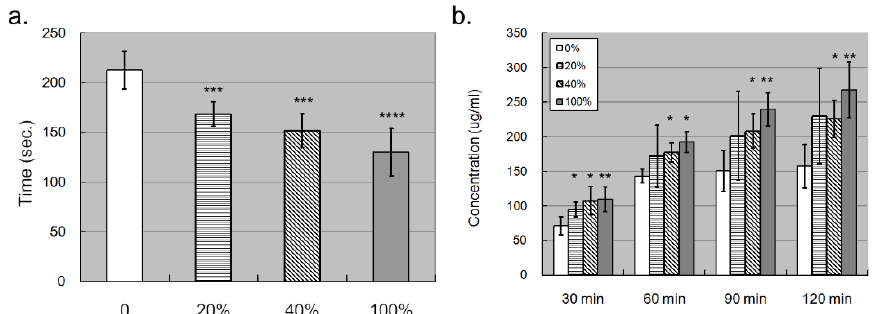
Figure 5. Trans-well assay showed that S100A4 promoted the permeability of the endothelial layer composed of HCAECs. We also used trans-well kits to examine whether S100A4 affected the per- meability of the endothelial layer. ( a ) The permeability of the endothelial layer was quantified by counting how much time was needed for trypan blue to reach the lower chamber ( n = 3). ( b ) The permeability of the endothelial layer was quantified by measuring the concentration of total proteins in the lower chamber ( n = 3). Data were presented as mean ± SD. *, **, *** and **** with a denoted p -value < 0.05, 0.01, 0.001, and 0.0001, respectively. S100A4—S100 calcium-binding protein A4;